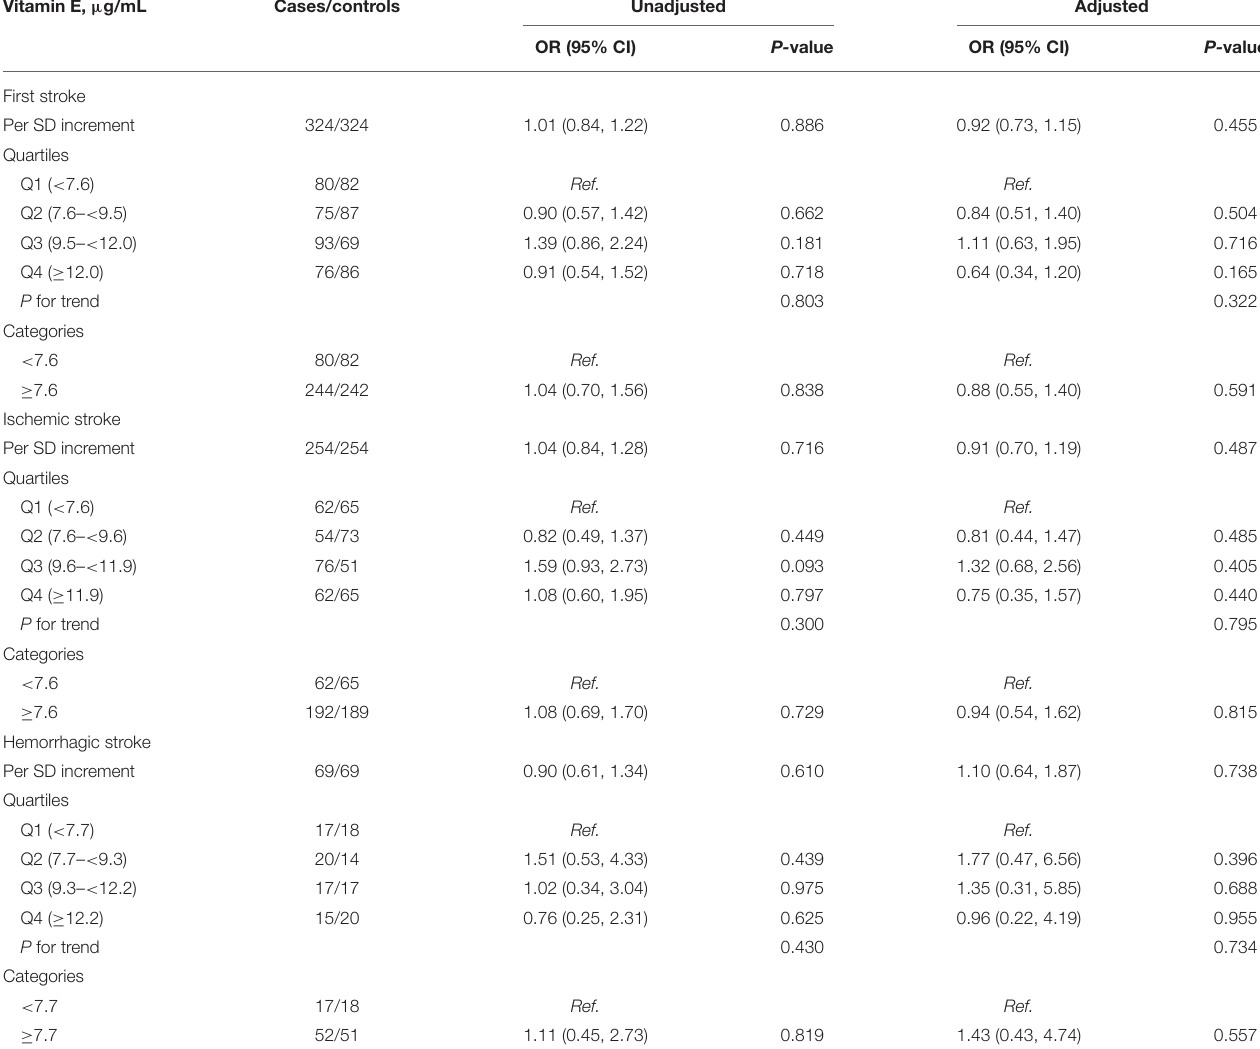
TABLE 3 | Relationship of plasma vitamin E with the risk of first stroke in females * . Vitamin E, µ